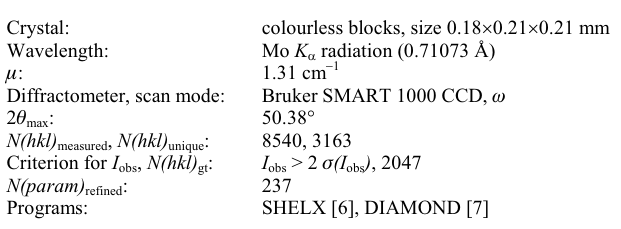
Table 1. Data collection and handling.